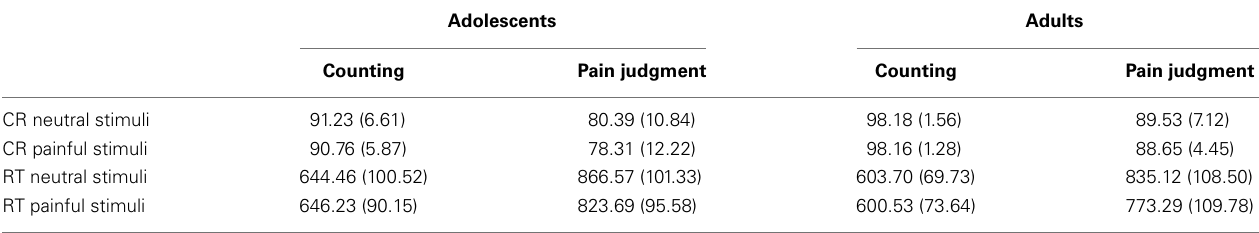
Table 2 | Mean response times (RT in ms) and accuracy (mean percentage of correct responses, CR) by condition and age